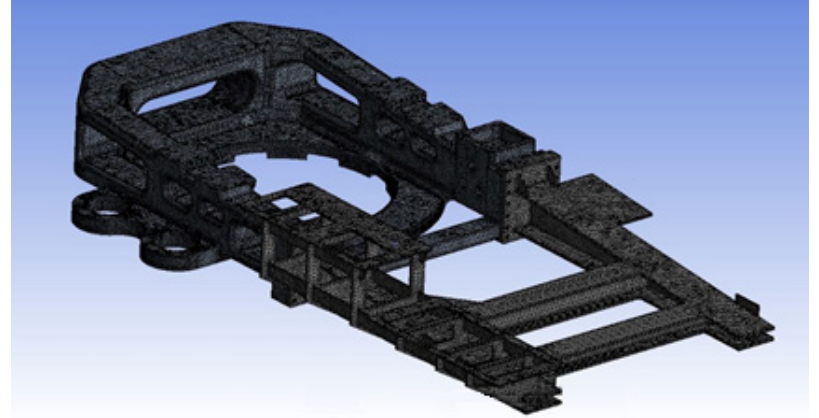
Figure 5. Meshed model of a sample bedplate [30].